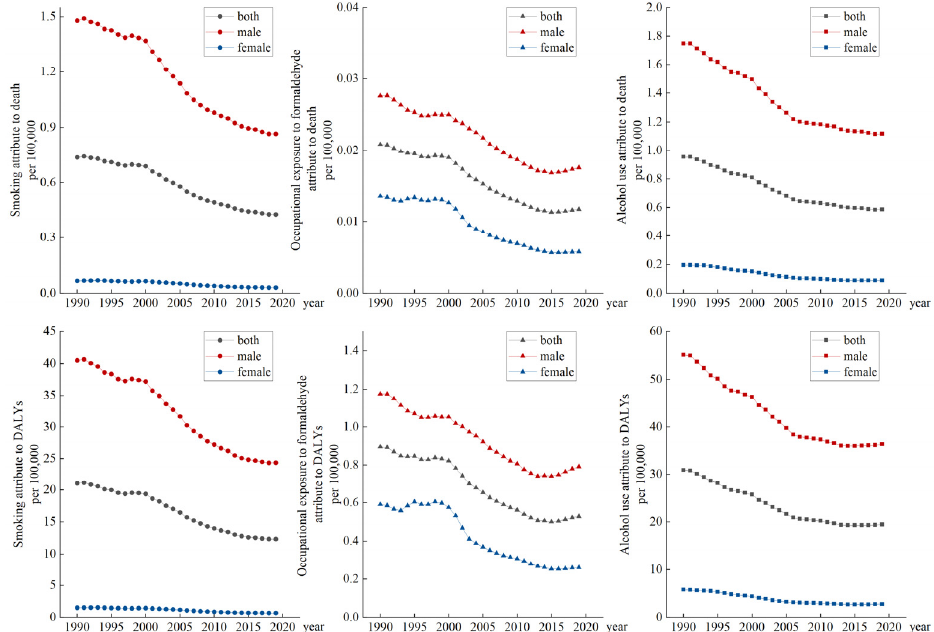
Figure 2. The variation trends of ASDR and age-standardized DALY rates of three risk factors in different genders over 30 years.